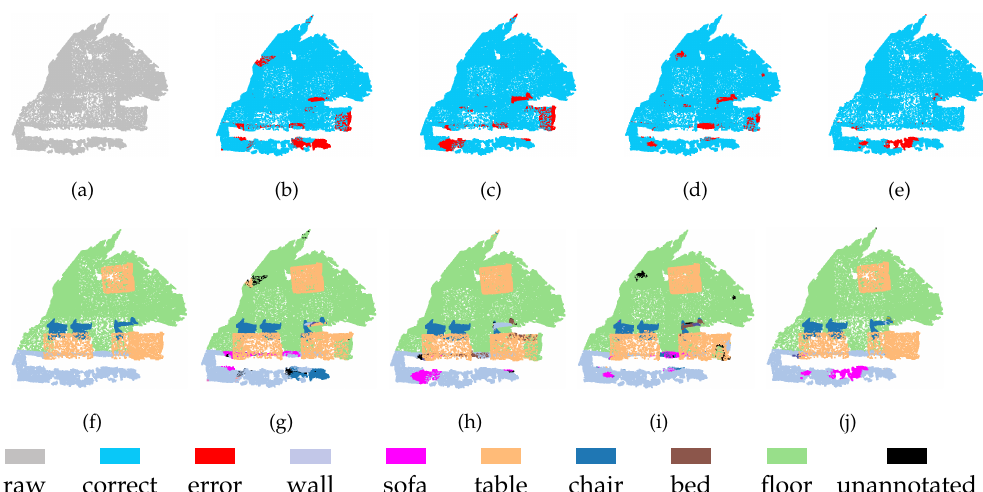
Figure 11. Segmentation results on ScanNet-2 dataset. ( a ) input, ( f ) ground truth, ( b , g ) PointNet++, ( c , h ) PointSIFT, ( d , i ) SAN, and ( e , j ) MSSCN.